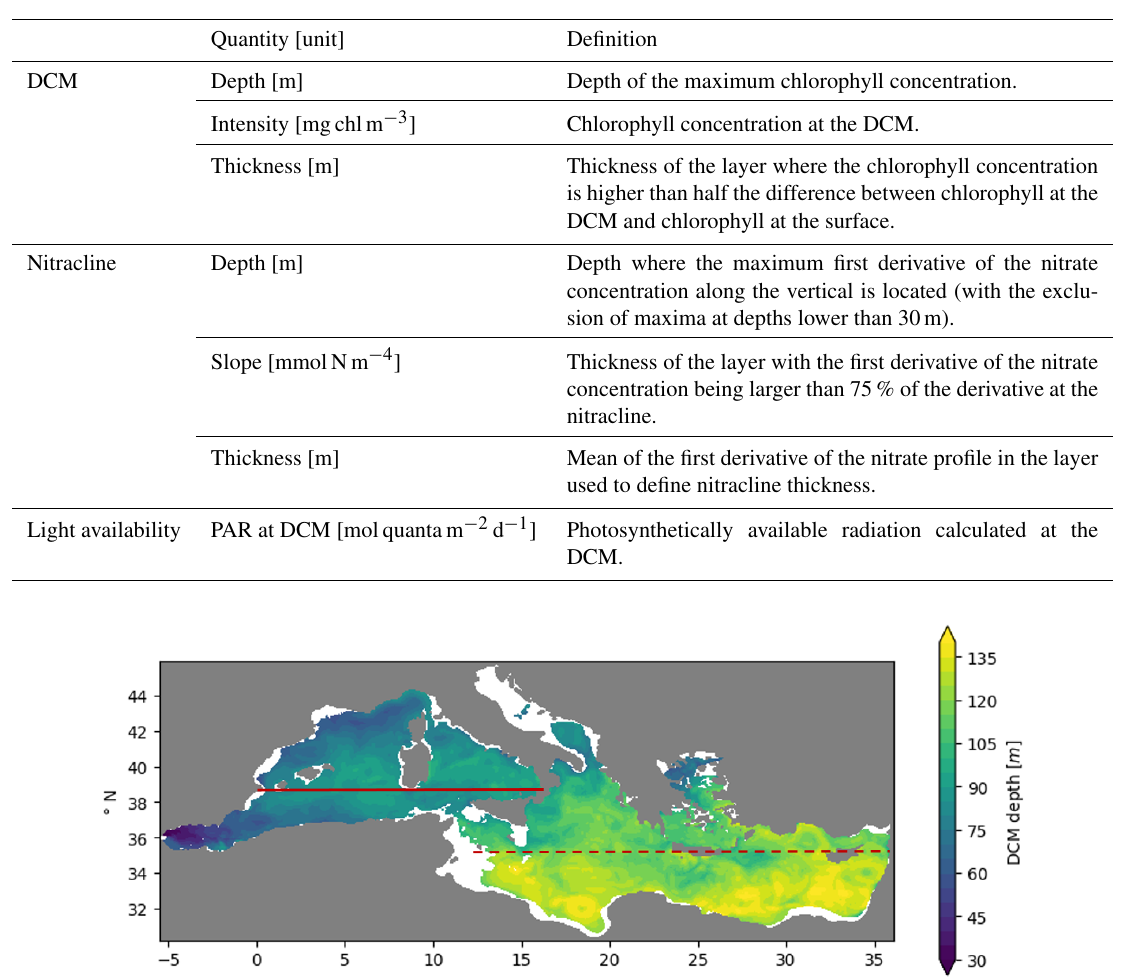
Table 3. Indexes evaluated in simulation ScFcn during summer stratification.